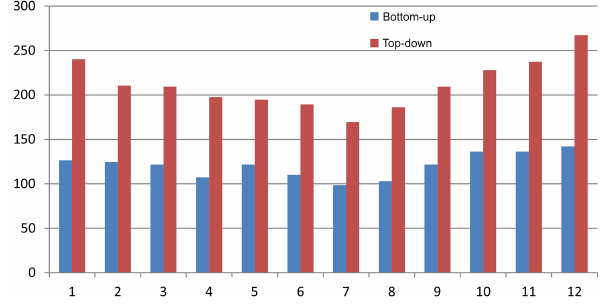
Figure 9. Seasonality of BC emission in China (units: